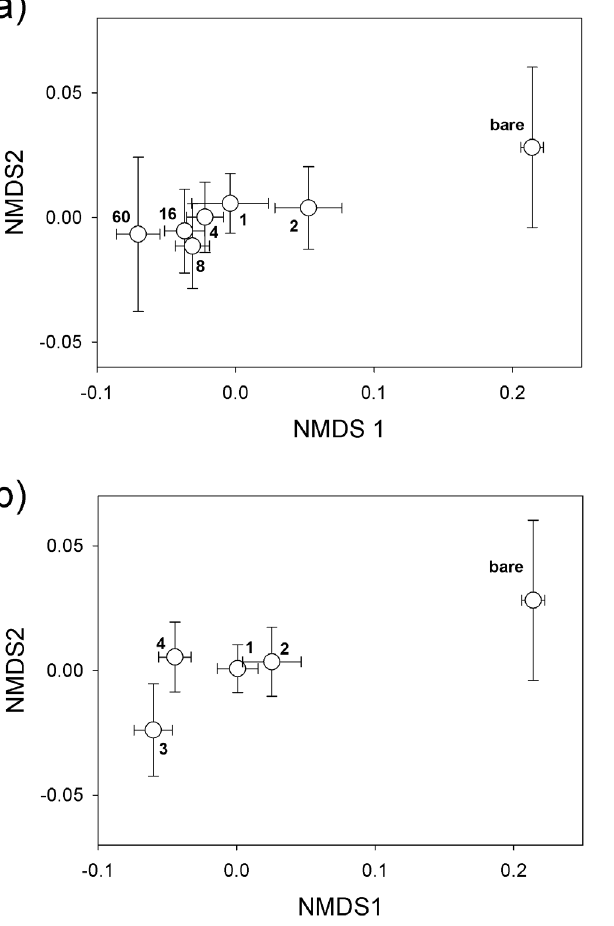
legumes, but increased with increasing number of plant functional groups to almost the same extent. These relationships could not be explained by our measured covariables.